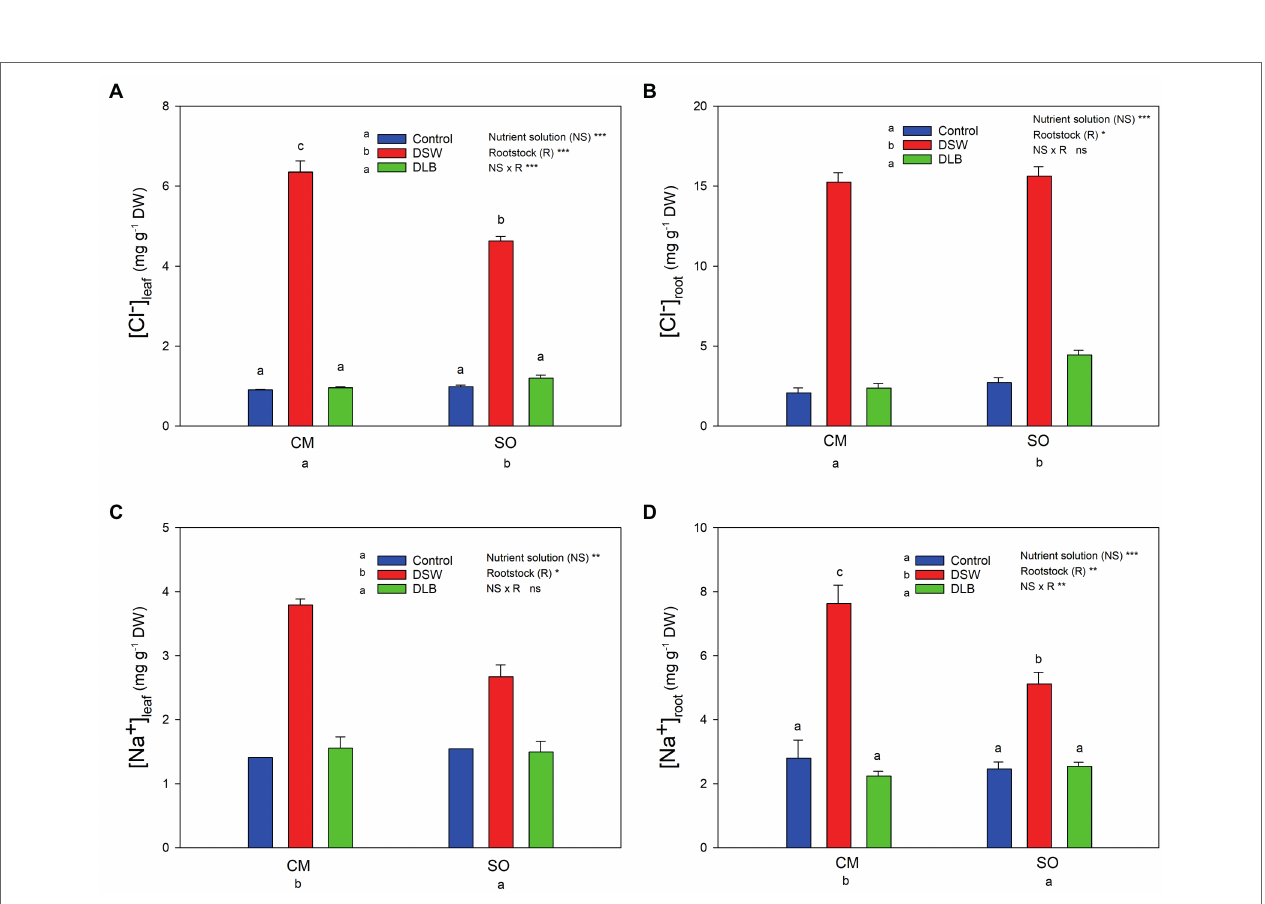
FIGURE 2 | Effects of 7 months of irrigation with nutrient solutions of different characteristics—Control, DSW, and DLB—on the Cl − (A,B) and Na + (C,D) concentrations in leaves and roots of ‘Verna’ lemon plants grown on two rootstocks, Citrus macrophylla (CM) and sour orange (SO). Different letters indicate significant differences according to Duncan’s multiple range test at the 95% confidence